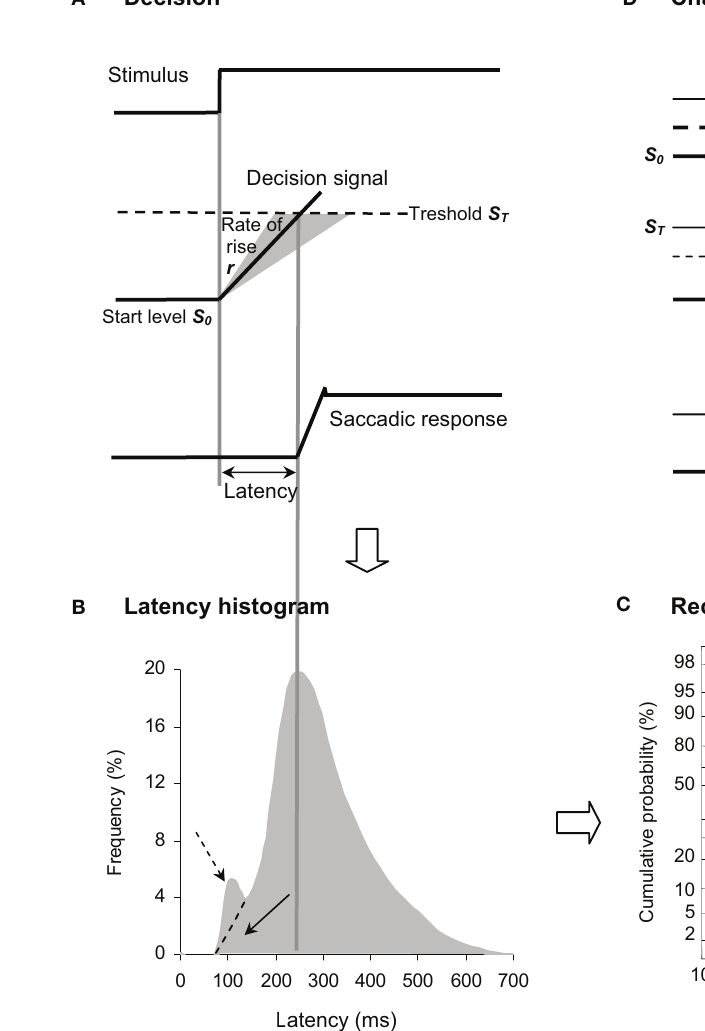
FIGURE 1 | (A) LATER model. From top to bottom , we show the stimulus signal, the theoretical decision signal in a LATER unit, and the saccade signal. In response to the Stimulus, the Decision signal initiates at the Start level S 0 and increases at a Rate of rise r until it reaches the Threshold S T at which the Saccadic response is initiated. (B) Traditional histogram of Frequency (in %) as a function of Latency (in ms). The main distribution is skewed with a tail to the right, and some population of express (dashed arrow) vs. early (full arrow) saccades can occur exhibiting or not a distinct peak, respectively.